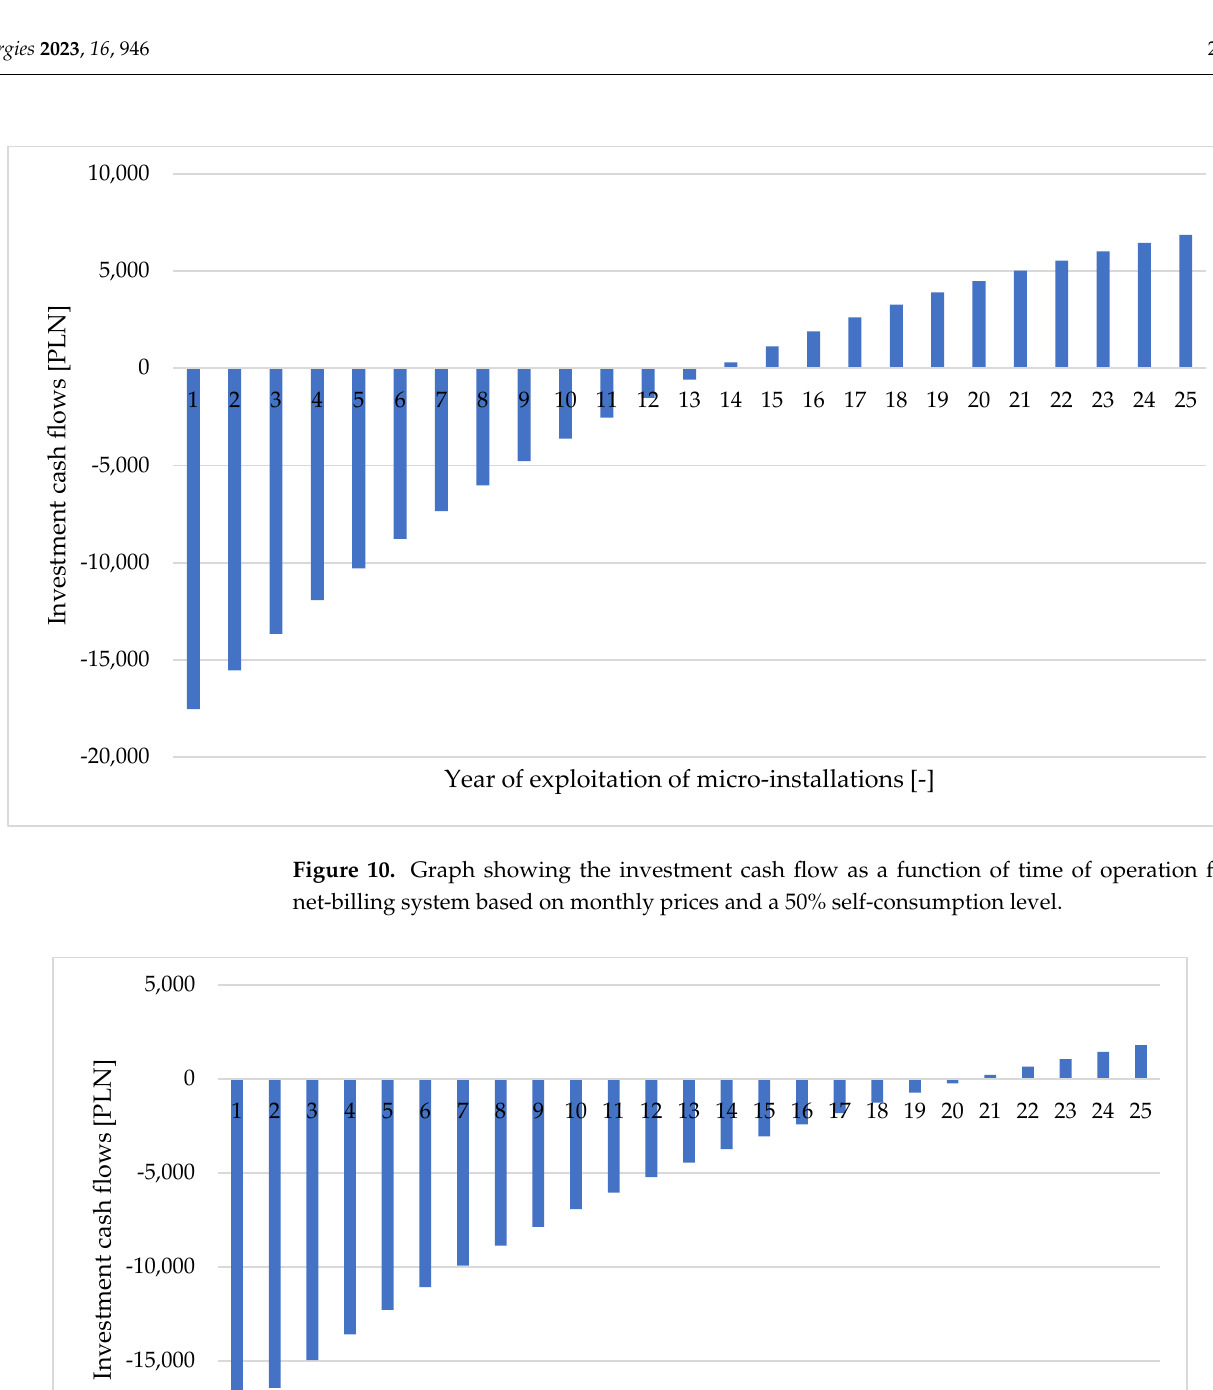
Figure 9. Graph showing the payback period for the capital expenditures incurred in relation to the net-metering system and the 50% self-consumption level.